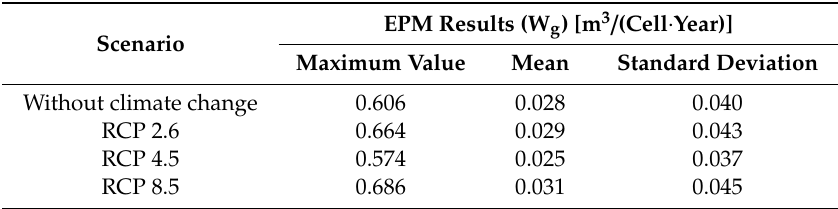
Table 11. Results of the statistical trend of the data in the Guerna catchment, considering di ff erent scenarios and using the EPM model.